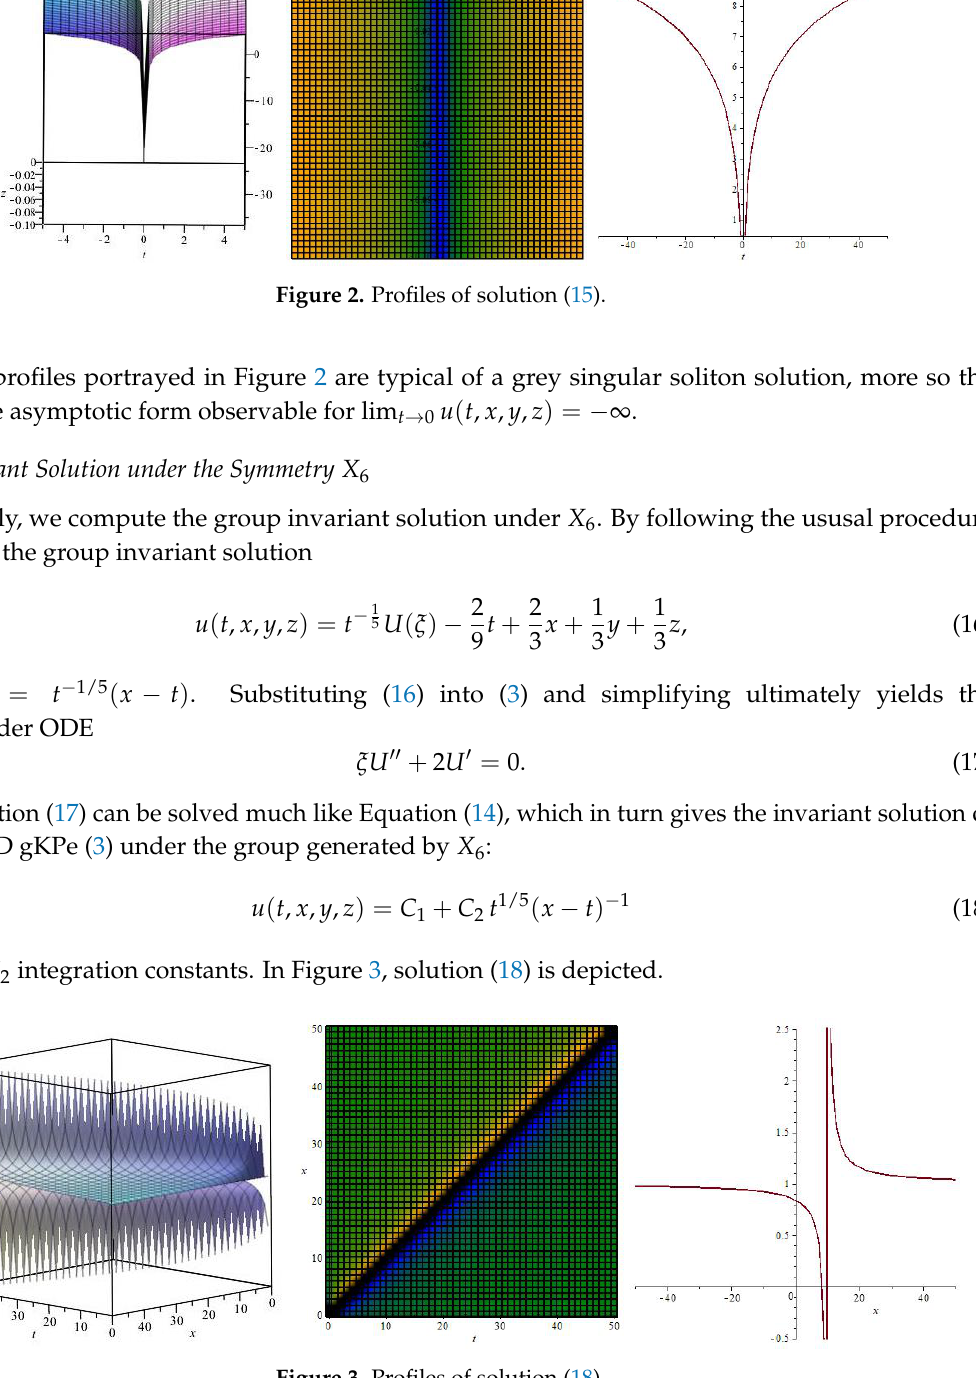
Figure 3. Profiles of solution